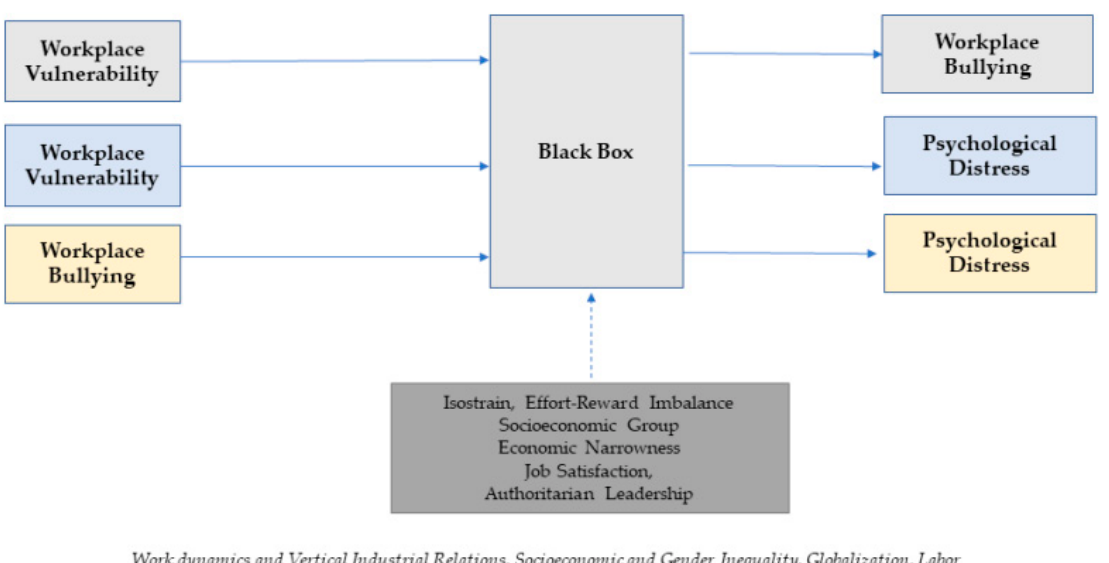
Figure 1. Theoretical framework by sex.